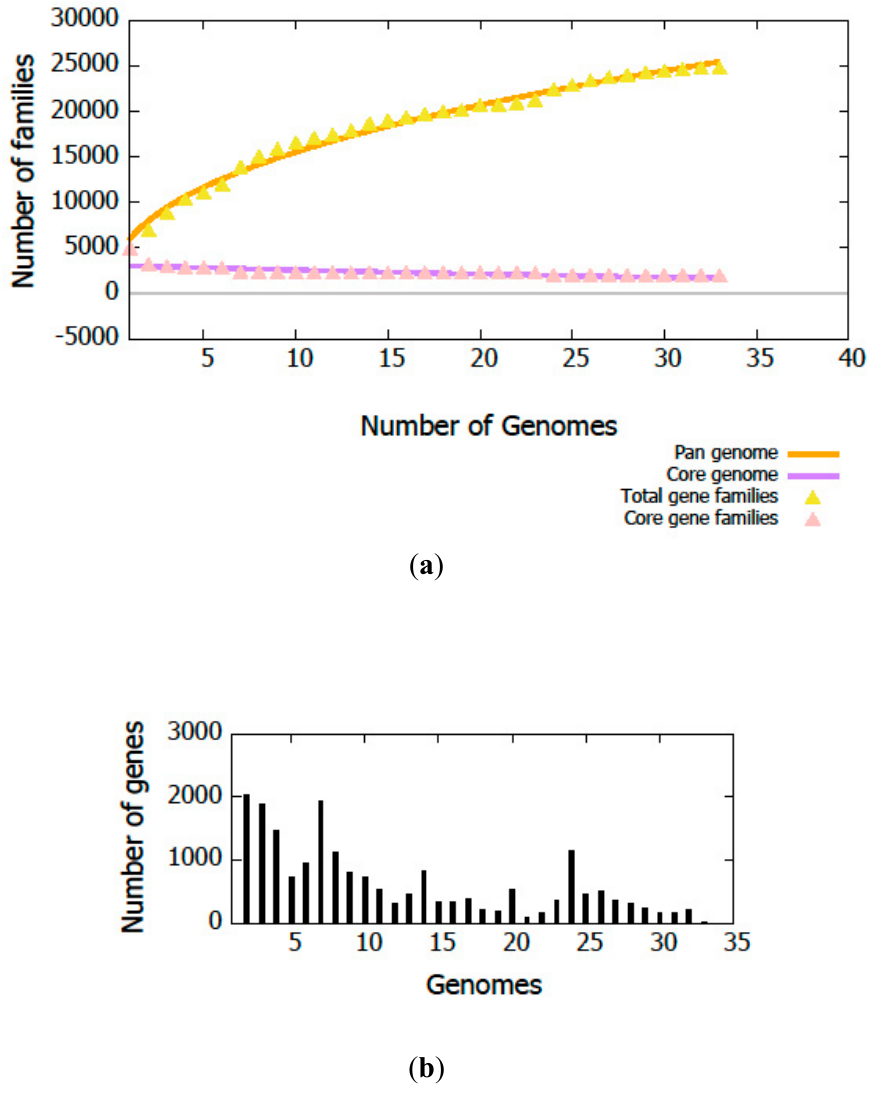
Figure 2. Pan-genome analysis based on the 33 studied genomes. ( a ) Core-pan plot; ( b ) number of new genes.